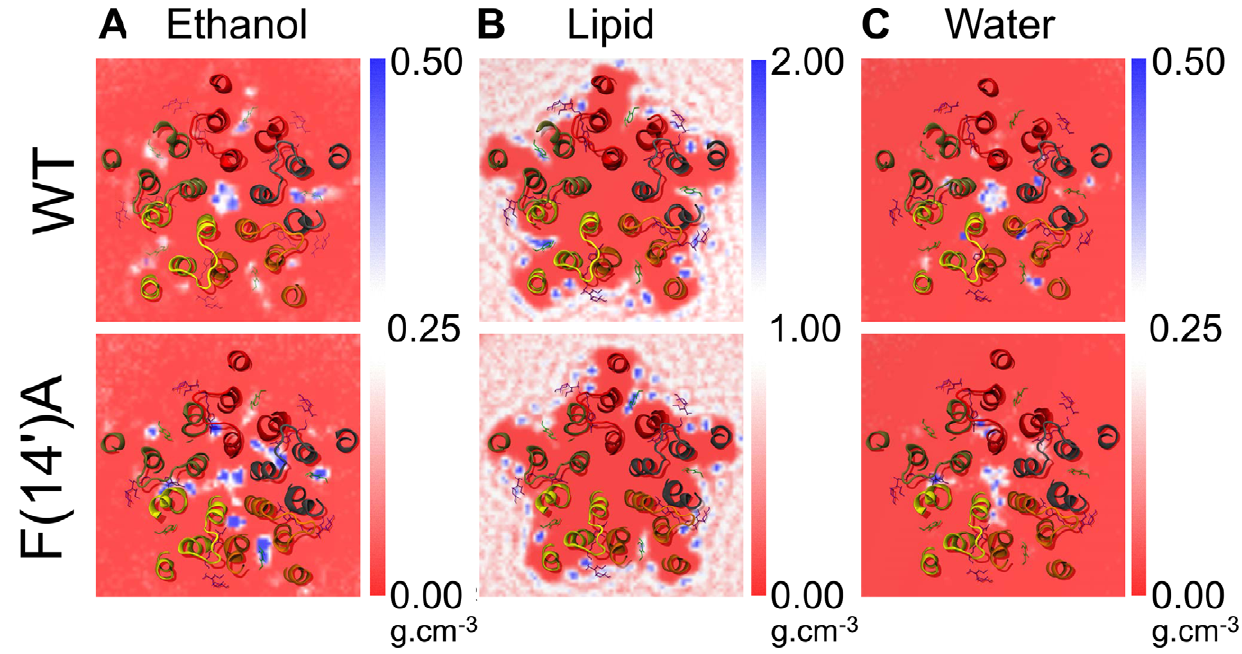
Figure 4. Effect of F(14 9 )A on the occupancy. ( A ) Ethanol, ( B ) DOPC, and ( C ) water density in the TMD. Densities were averaged over the complete trajectory of the WT ( upper panels ) and F(14 9 )A ( lower panels ) simulations with ethanol. The TMD is colored by chain. For comparison, crystal structures of the GLIC complex with propofol (PDB ID 3P50) [23] and the GluCl complex with ivermectin (PDB ID 3RHW) [22] were aligned on the TMD C a atoms, and the corresponding propofol and ivermectin molecules were displayed as green and pink sticks, respectively. For WT, ethanol bound predominantly in the intra-subunit cavity in a similar position to propofol; in F(14 9 )A, ethanol bound to the intra- and inter-subunit cavities equivalently.